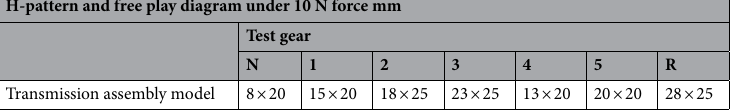
Table 3. H-Pattern and free play diagram under 10 N force.